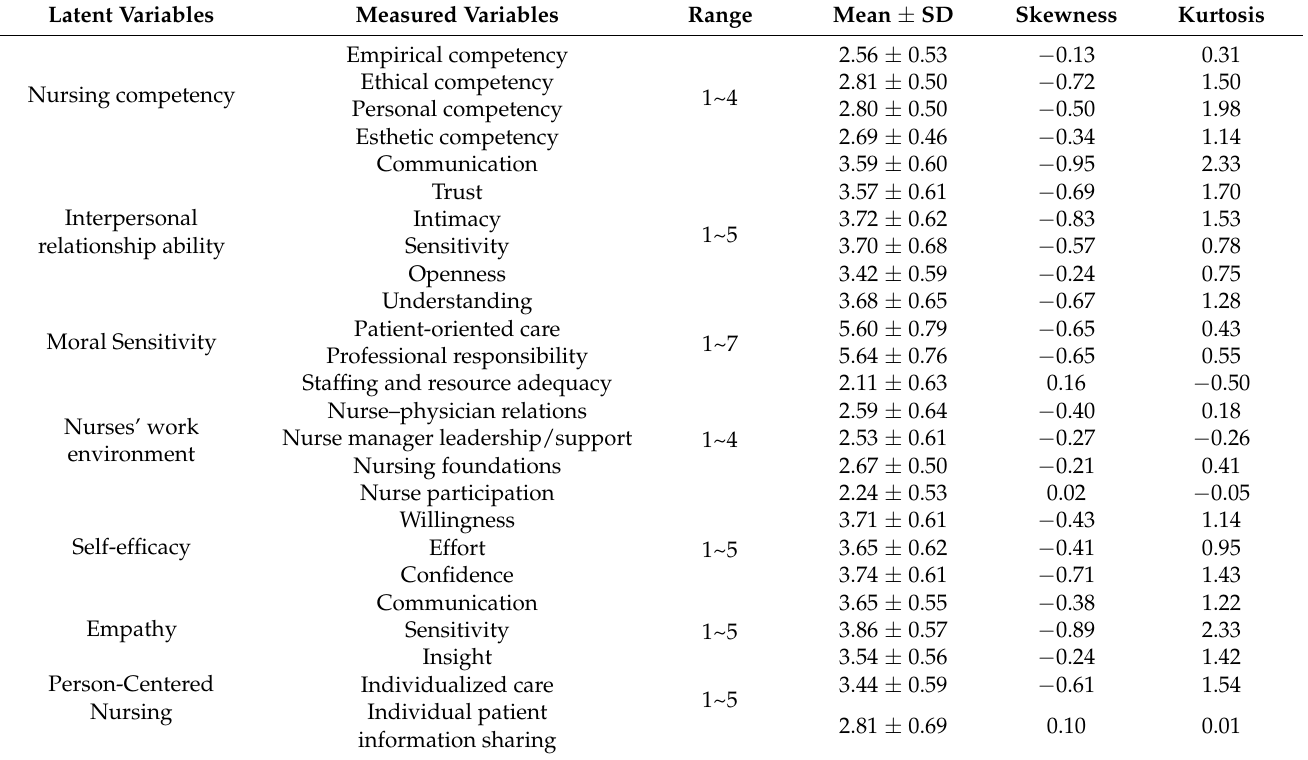
Table 2. Descriptive Statistics of Measured Variable ( N =